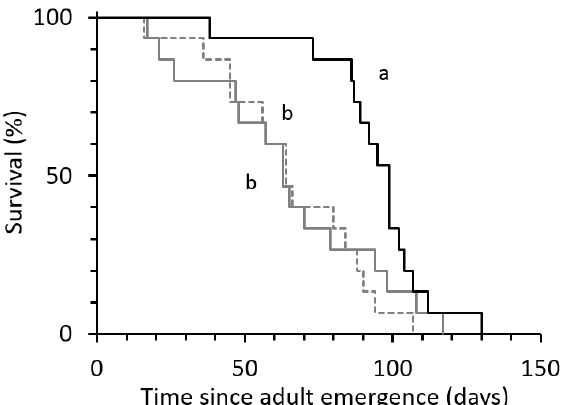
Figure 1. Kaplan–Meier survival curves of Chrysoperla agilis females, depending on the duration of male availability to females for mating: (1) Virgin females (compact black line, n = 15); (2) 1 week mating: the male present for 1 week (gray line, n = 15); (3) lifetime: male present for the female’s lifetime (dotted gray line, n = 15). Different letters on each curve indicate significant differences between treatments (log rank test, p < 0.05).